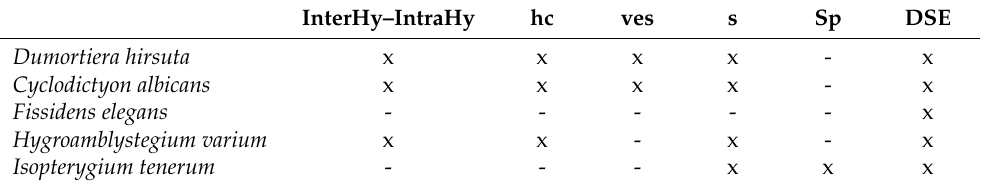
Figure 4. Inter- (InterHy), intracellular hyphae (IntraHy) and hyphae in coils (hc). of dark septate endophyte fungi (DSE). ( a ) Dumortiera hirsuta . ( b ) Hygroamblystegium varium . [Bars = 50 µm].